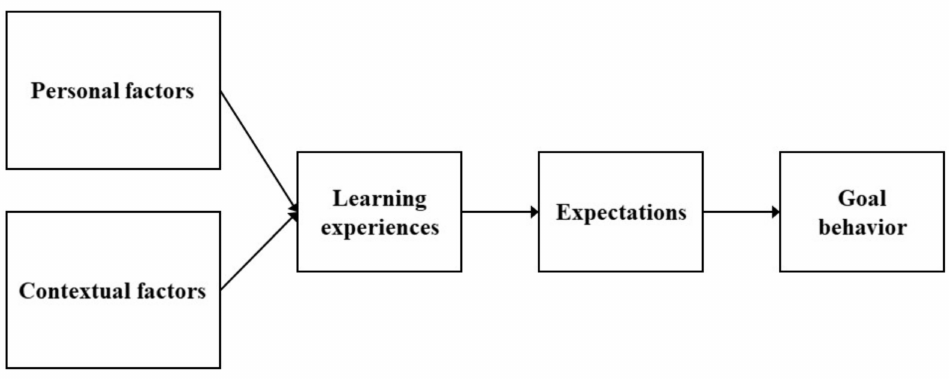
Figure 1. The conceptual framework of this study, based on the social cognitive career theory by Lent, Brown, and Hackett